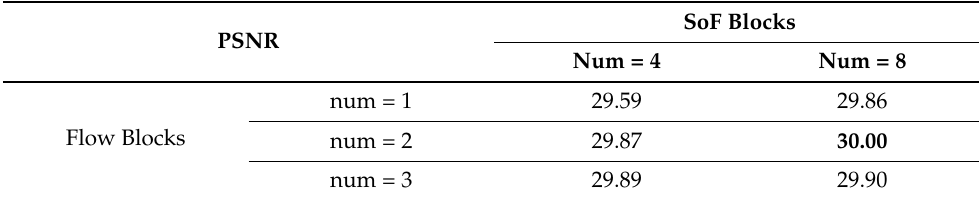
Table 4. Comparisons on the denoising accuracy of different numbers of DownScale Blocks and Invertible Blocks.